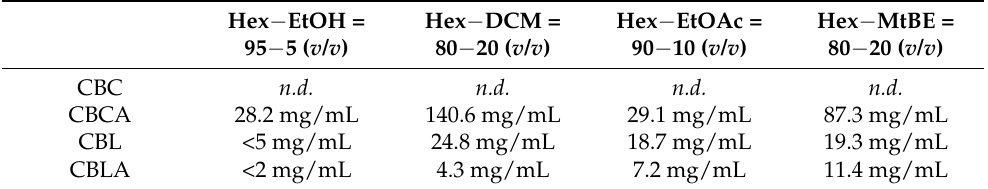
Table 6. Solubility comparison of cannabinoids in traditional and non-traditional normal-phase mobile